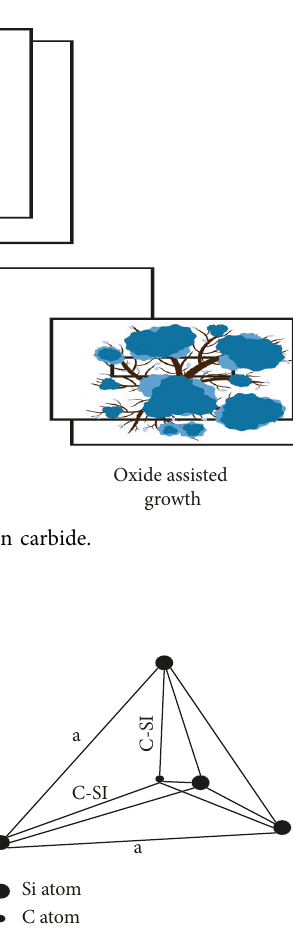
Figure 3: Schematic diagram of the tetrahedral structure of silicon